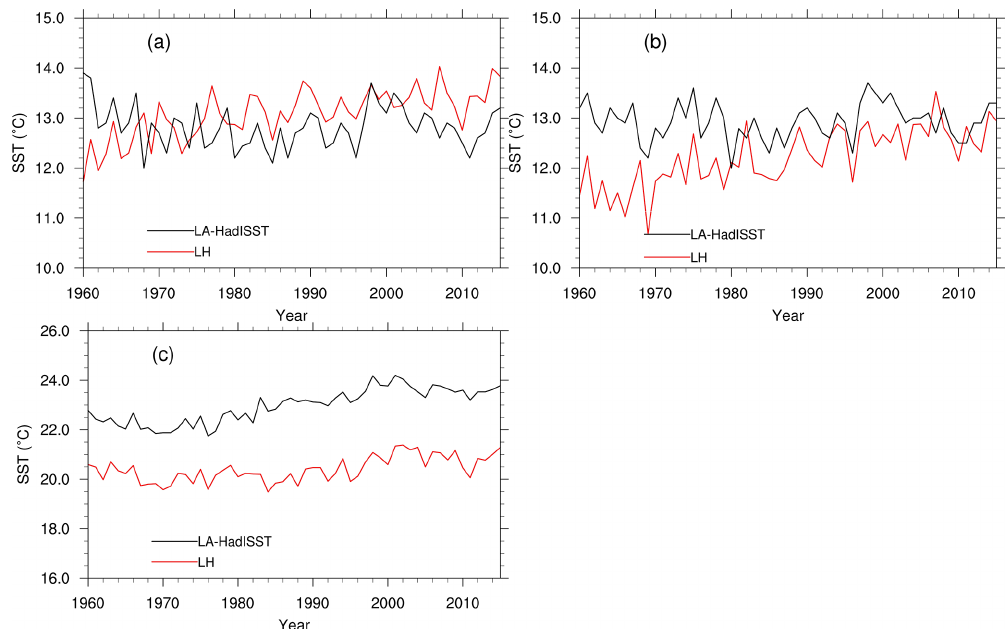
Figure 2. The annual mean SST series of LA-HadISST (black line) and LH (red line) from Station 1 (Zhimaowan) (a) and Station 2 (Qinhuangdao) (b) . The average annual mean SST series of LA-HadISST (black line) and LH (red line) from Station 15 (Pingtan) to Station 19 (Yunwo) (c) .